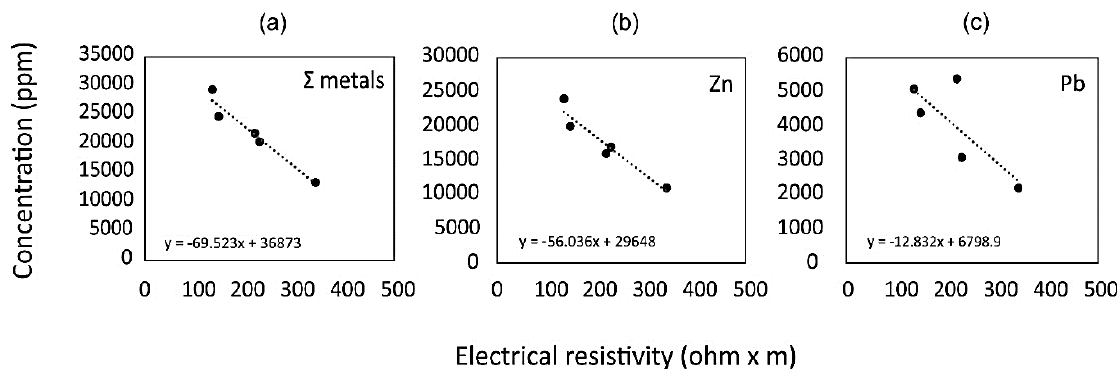
Figure 6. Scatterplots between metal content in the samples from borehole S3 vs. ERT inverted resistivity values. ( a ) Sum ( Σ ) of metals include Zn, Pb, Tl, Cd, Cu, Ni, Sb and Cr whereas only Zn and Pb concentrations are reported in ( b ) and ( c ), respectively.